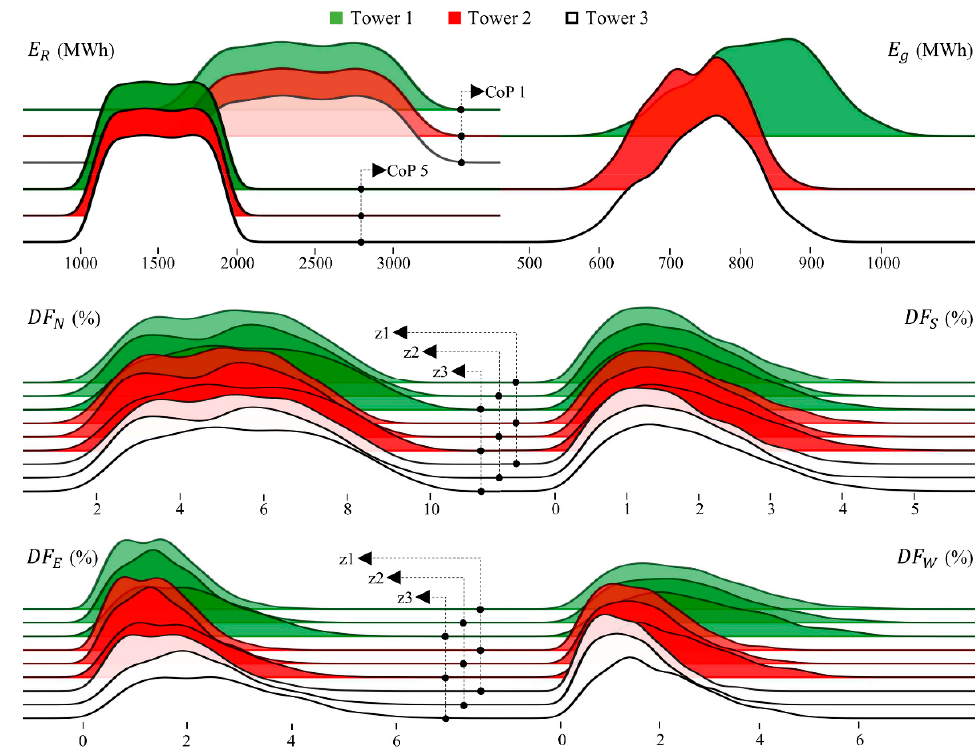
Figure 12. Distributions of collected samples.